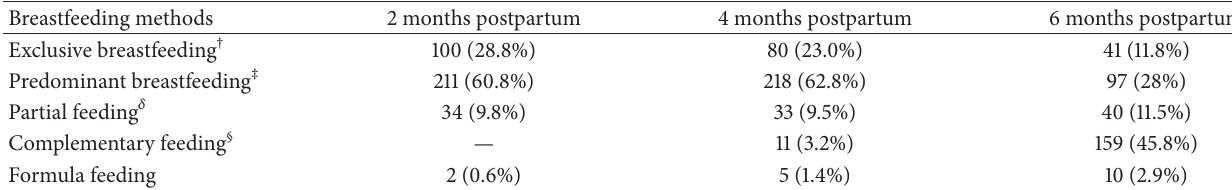
Table 2: Frequency of different breastfeeding